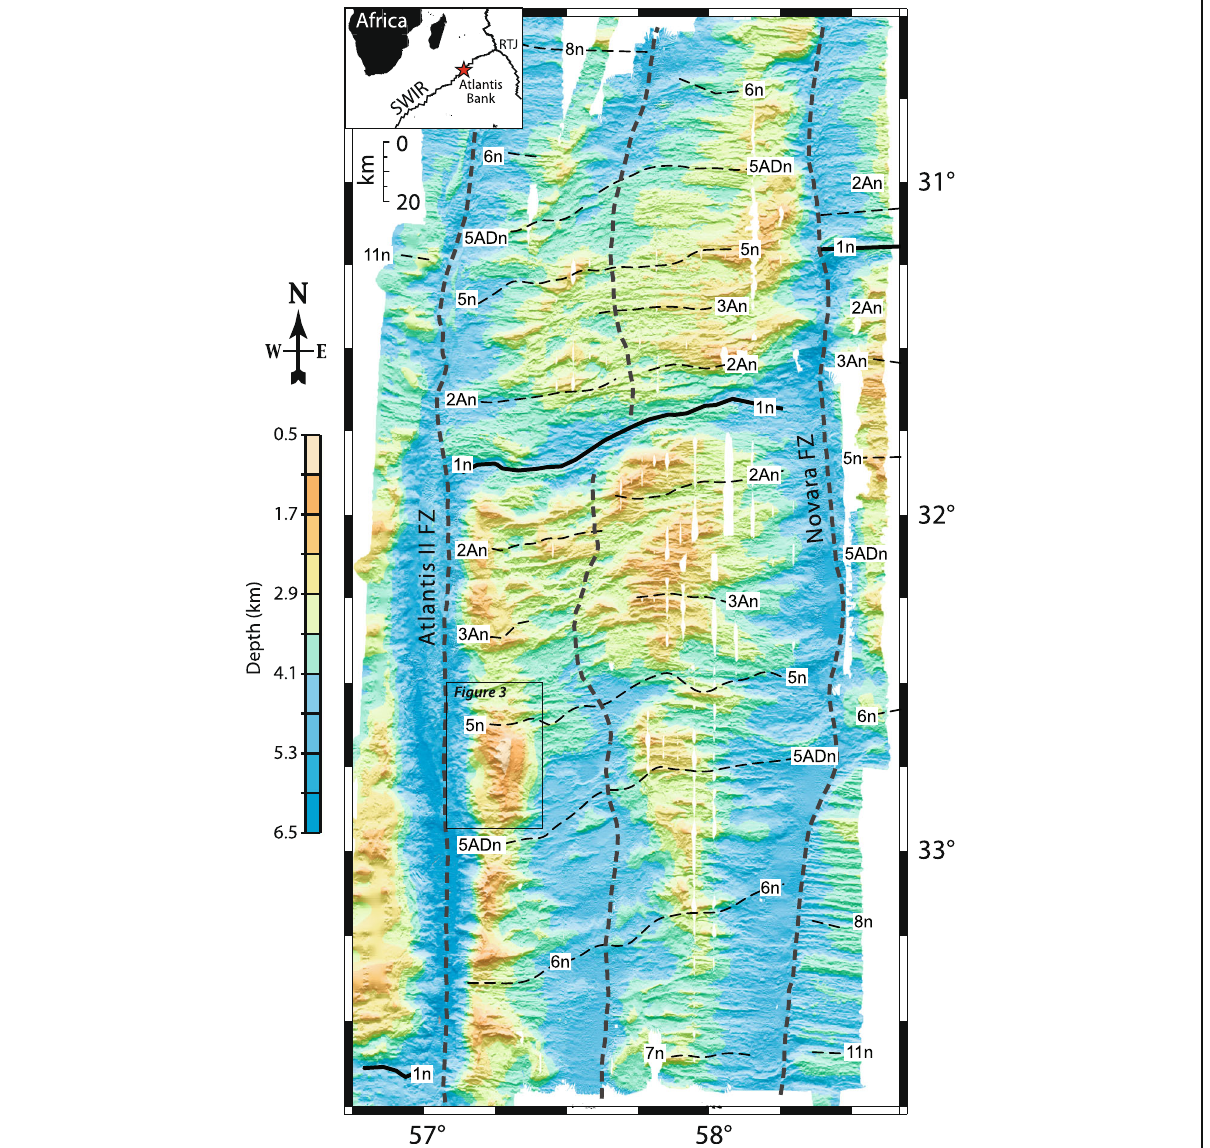
Fig. 2 SWIR shaded relief map for 56°45'E to 59° E overlain by the Atlantis Bank geologic map. The east-west dashed lines indicate magnetic anomaly picks with the central anomaly (1n) indicated by the solid line. The north-south lines delineate the segmentation pattern and fracture zone locations (modified from Baines et al. 2007). JAMSTEC bathymetry compiled by (Hosford et al. 2003). Inset shows the SW Indian Ridge and the Rodriguez Triple Junction